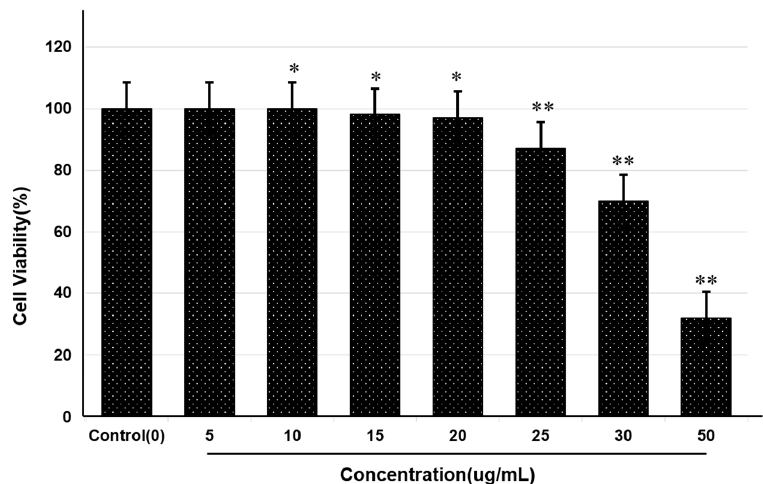
Figure 3. Toxicity determination of theasaponin E1 on mouse neuroblastoma cells by MTT assay. Percentage cell viability was determined for control and various concentrations of theasaponin E1.